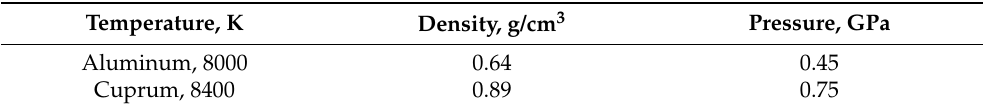
Table 1. Critical parameters of